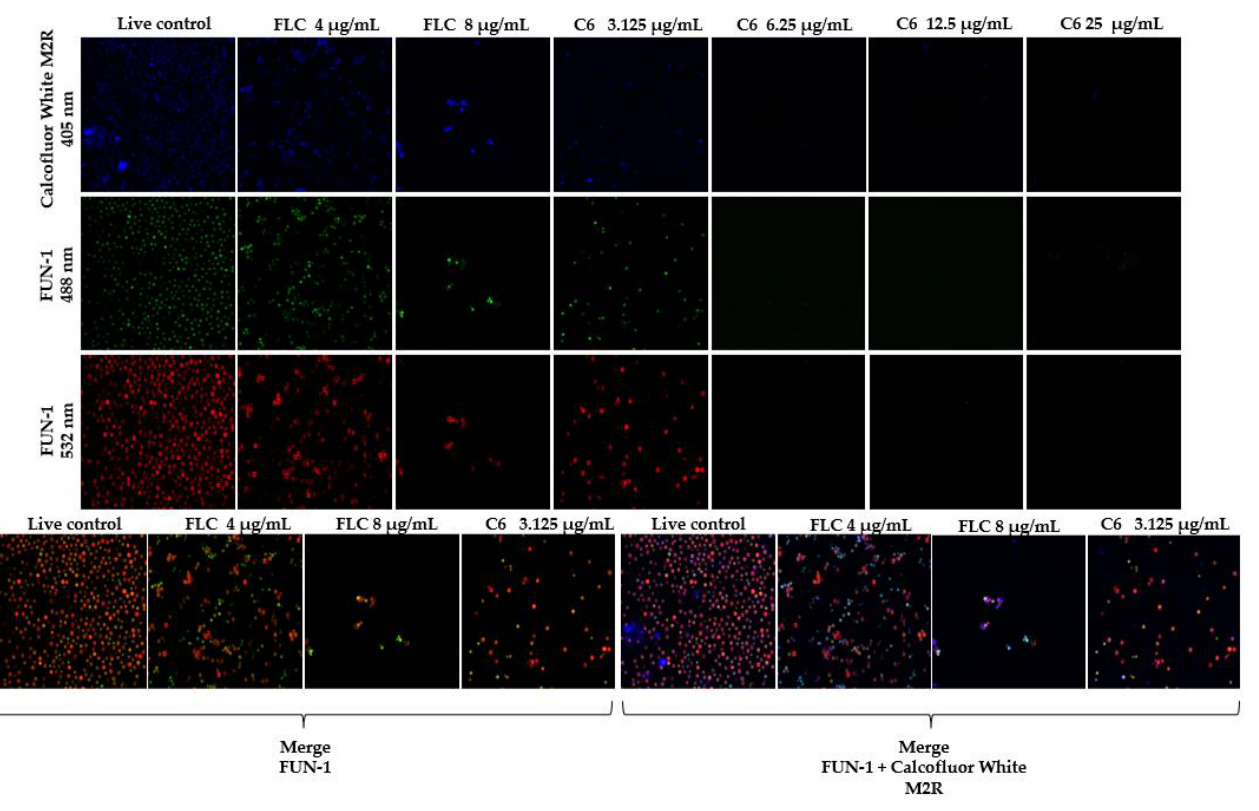
Figure 2. Cell viability assay of C. neoformans var. grubii after treatment (72 h) with C6 at 3.125 µg/mL, 6.25 µg/mL 12.5 µg/mL, and 25